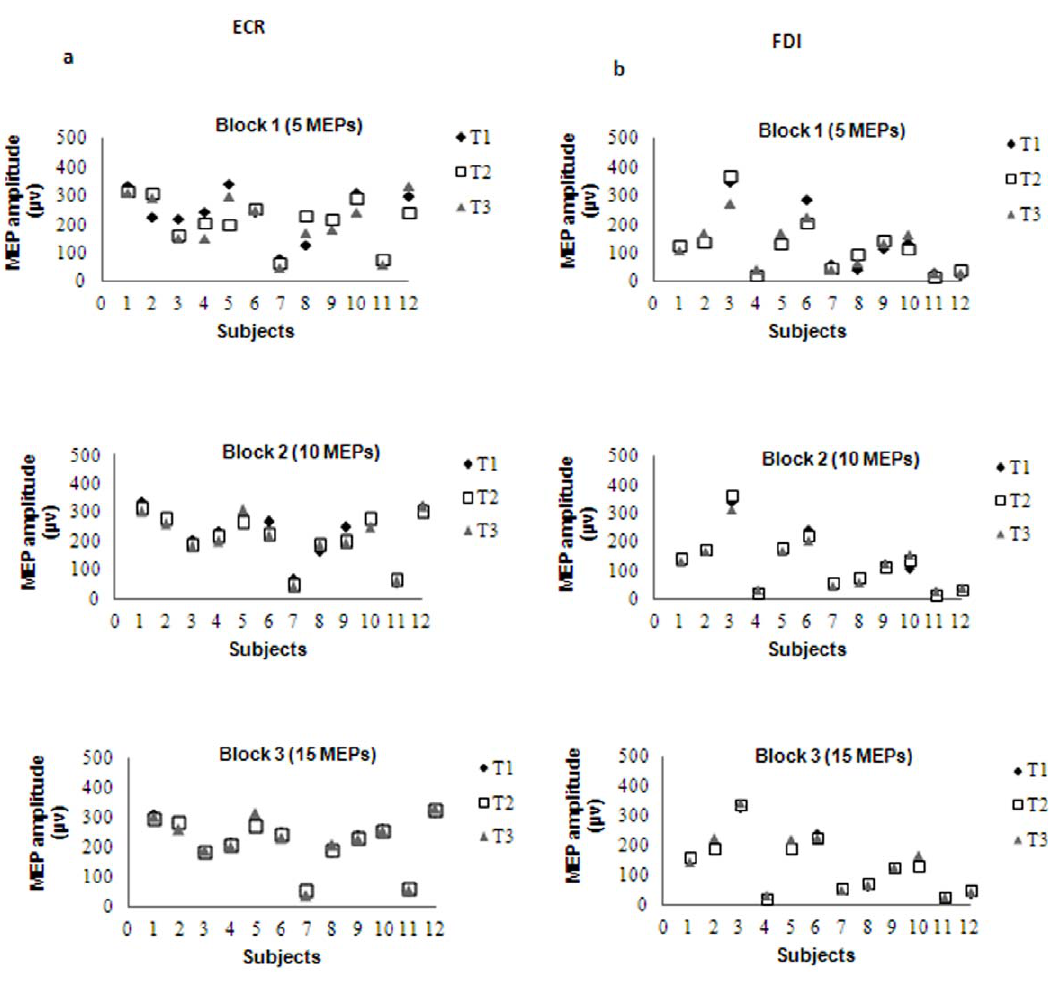
Figure 2. Comparison of MEPs amplitude in 12 subjects within a session. a) ECR, and b) FDI muscles with 5, 10 and 15 MEPs per block in three time points. doi:10.1371/journal.pone.0047582.g002 and 2). Repeated measures ANOVA revealed no significant time effect in any of the measurements for ECR muscle and FDI muscles (Tables 1 and 2).